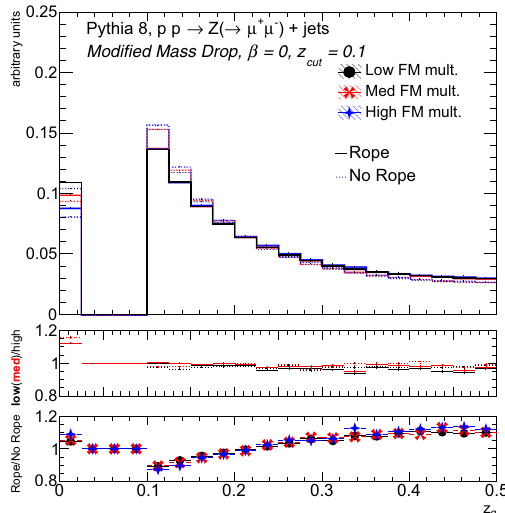
panel, the ratio between the Rope and standard hadronization models is displayed for all three multiplicity regions. Due to the algorithm value z cut = 0 . 1, z g ≥ 0 . 1; when the entire jet is groomed away, z g = 0. The corresponding plots for TTM and ZTM are in the appendix, Fig. 20